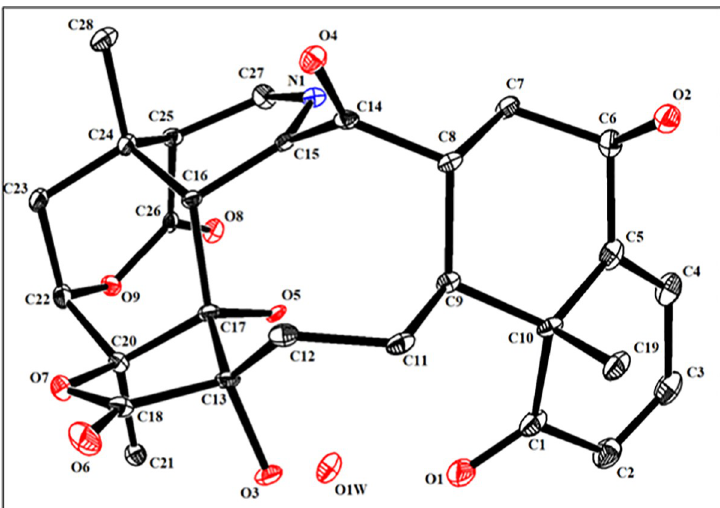
Fig 3. ORTEP view of compound 1 at 50% probability